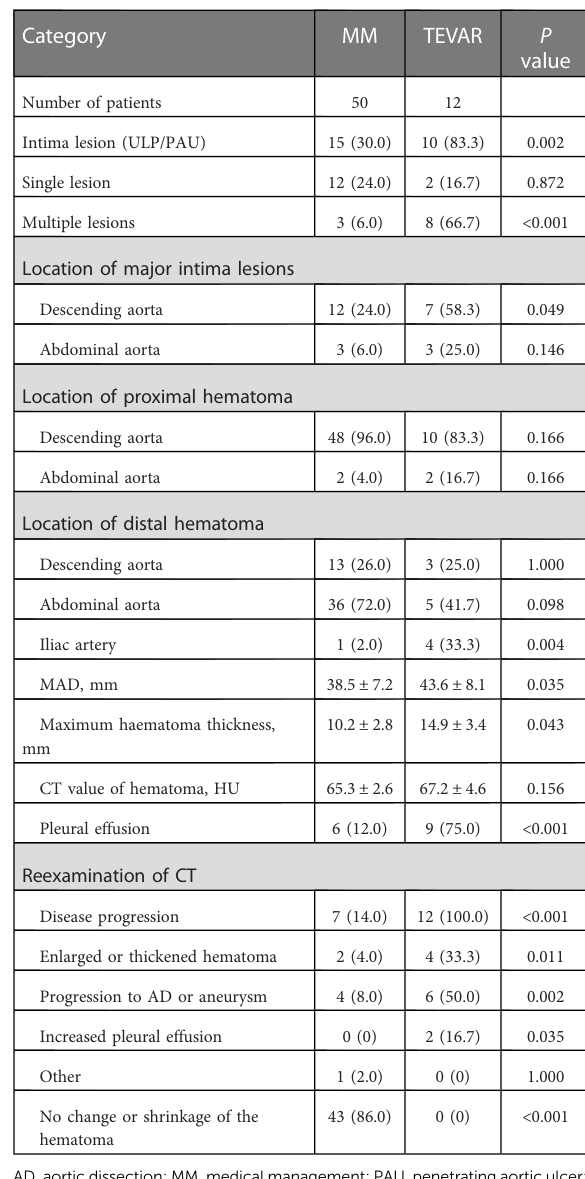
TABLE 4 Ct imaging of TEVAR group and MM